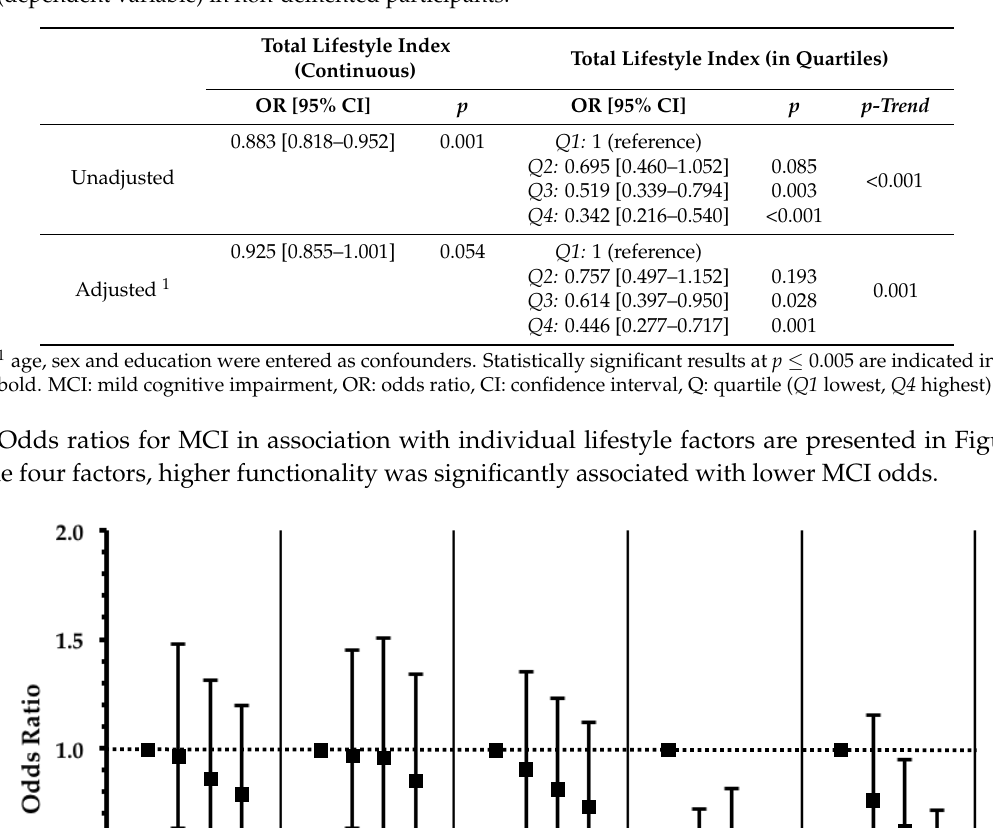
Table 4. Results from logistic regression analysis that evaluated the association between TLI and MCI (dependent variable) in non-demented participants.